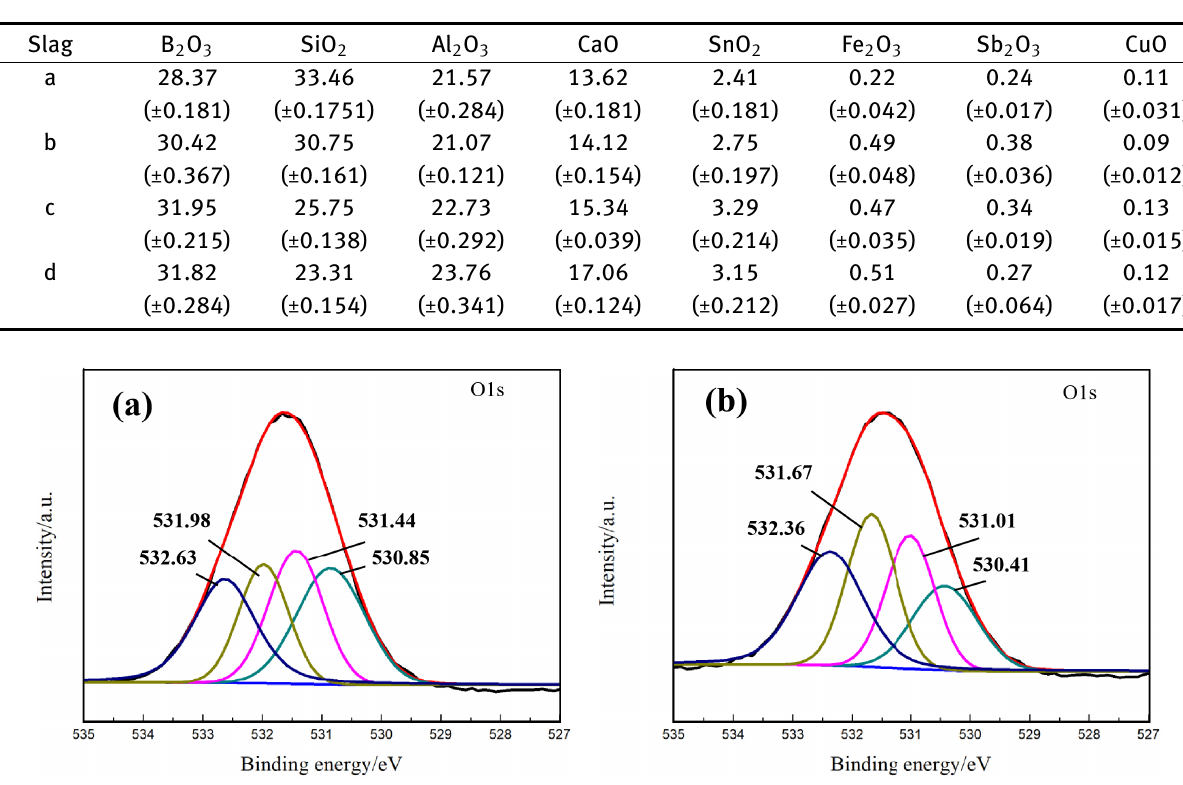
Table 3: XRF result of slag (wt.%)